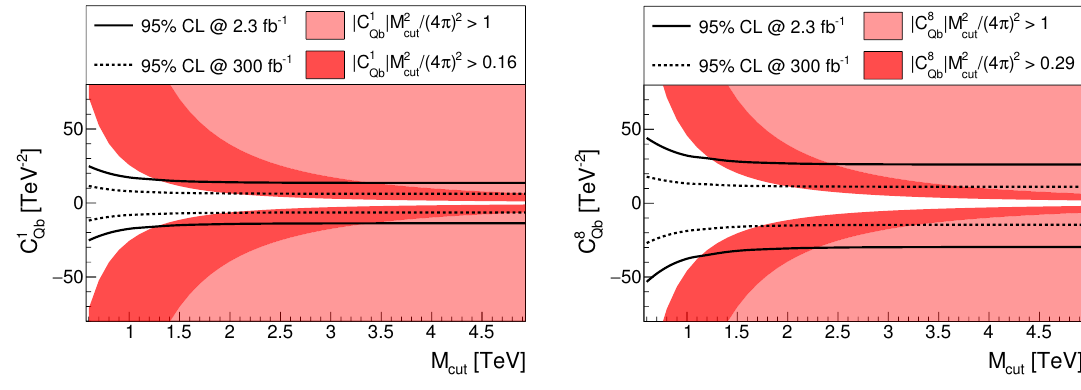
Figure 4 . Limits at 95% CL on C 1 for an integrated luminosity of 2.3 fb (cid:0) 1 (full line) and projections to 300 fb (cid:0) 1 (dashed line). The non-perturbative regime of the EFT in which shaded region. The darker red region represents a more stringent perturbativity requirement for which the upper limit on the Wilson coe(cid:14)cient (at 300 fb (cid:0) 1 ) intersects the perturbativity threshold at M cut = 2